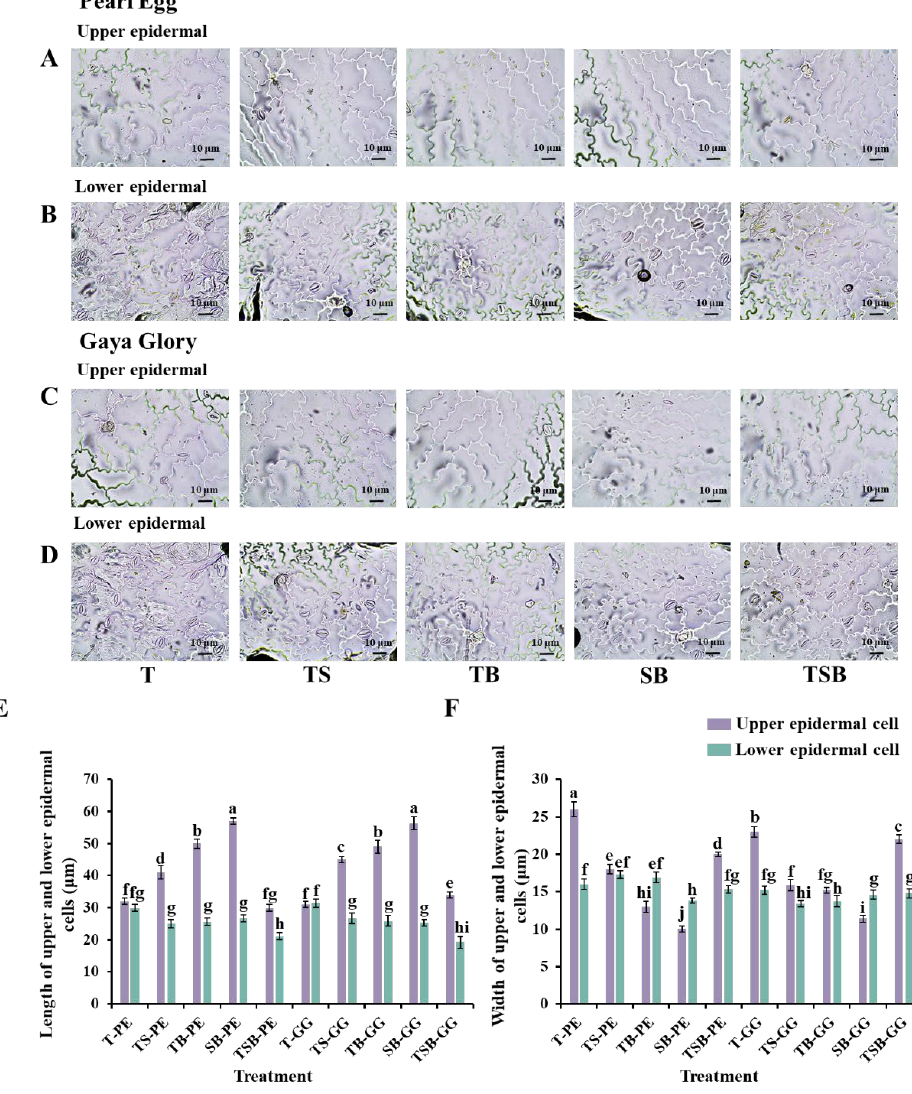
Figure 4. Changes in the epidermal cell morphology of chrysanthemum “Pearl Egg” and “Gaya Glory” plants as affected by the different lighting direction combinations. Micrographs of upper and lower epidermal cells of “Pearl Egg” ( A , B ) and “Gaya Glory” ( C , D ), length of upper and lower epidermal cells ( E ), and width of upper and lower epidermal cells ( F ) of “Pearl Egg” and “Gaya Glory” as affected by the different lighting direction combinations after 45 days of cultivation. T, TS, TB, SB, and TSB-PE/GG, refer to the top (1/1), top (1/2) + side (1/2), top (1/2) + bottom (1/2), side (1/2) + bottom (1/2), and top (1/3) + side (1/3) + bottom (1/3) lighting, respectively. Vertical bars in- dicate the means ± standard error ( n = 6). Different lowercase letters indicate significant separations within treatments by Duncan’s multiple range test at p ≤ 0.05. Bars indicate 10 μm.